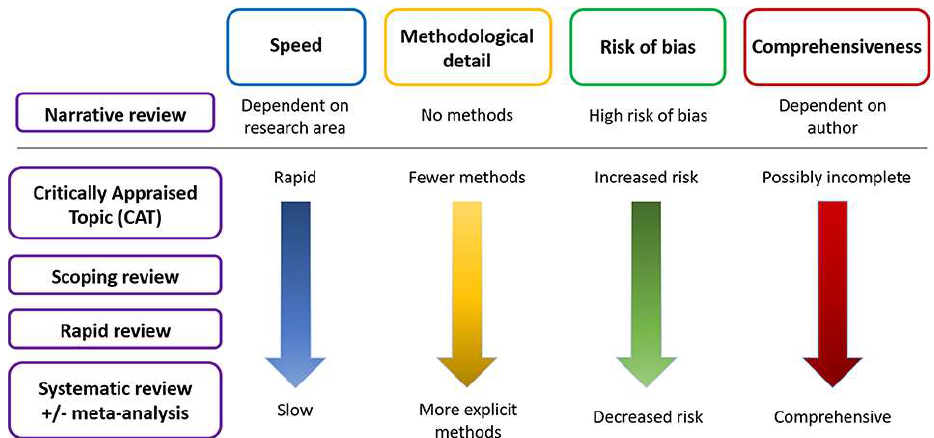
Figure 1. Comparison between the common types of evidence synthesis approaches (Adopted from Brennan et al., 2020 [38])